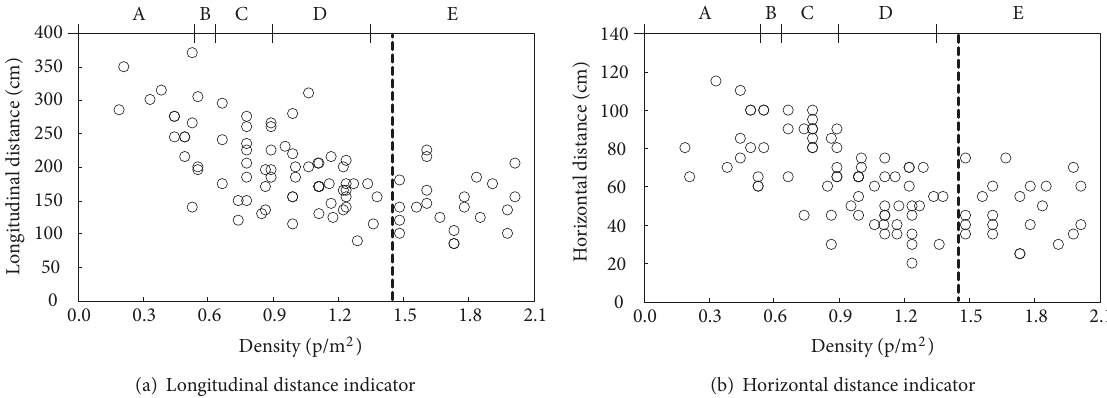
Figure 14: Microscopic distance indicators of pedestrian evasive behavior.